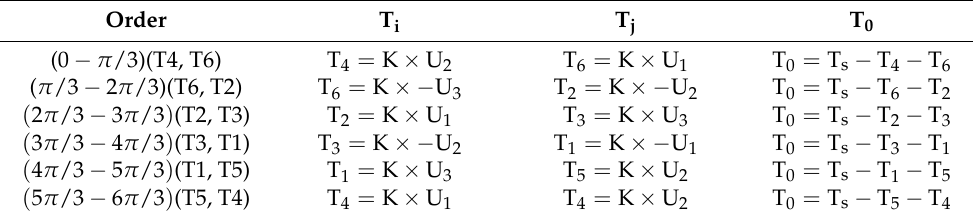
Table 7. Relationship between the sector action time and the sector.